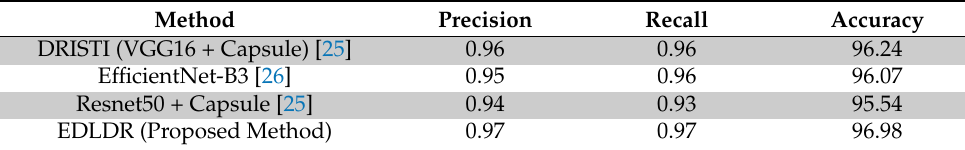
Table 6. Results comparison, two classes.